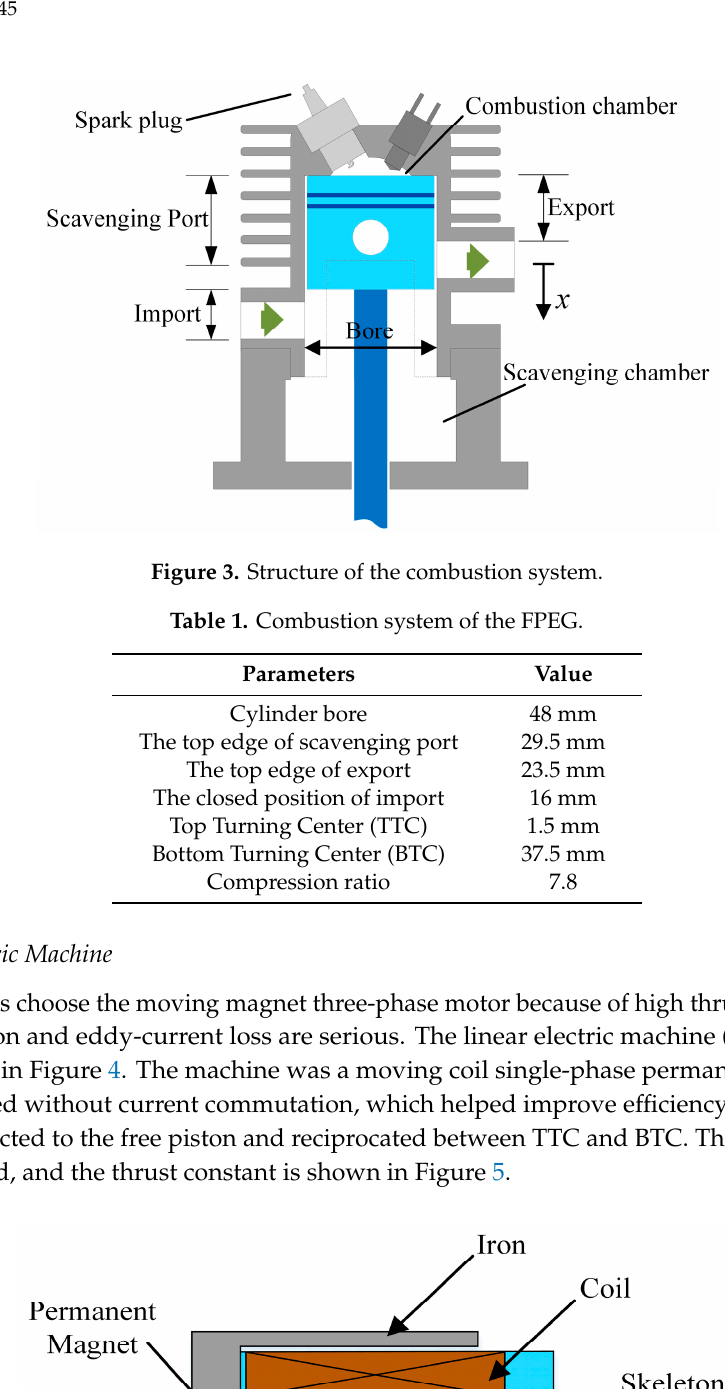
Figure 4. Structure of the linear electric machine (LEM).